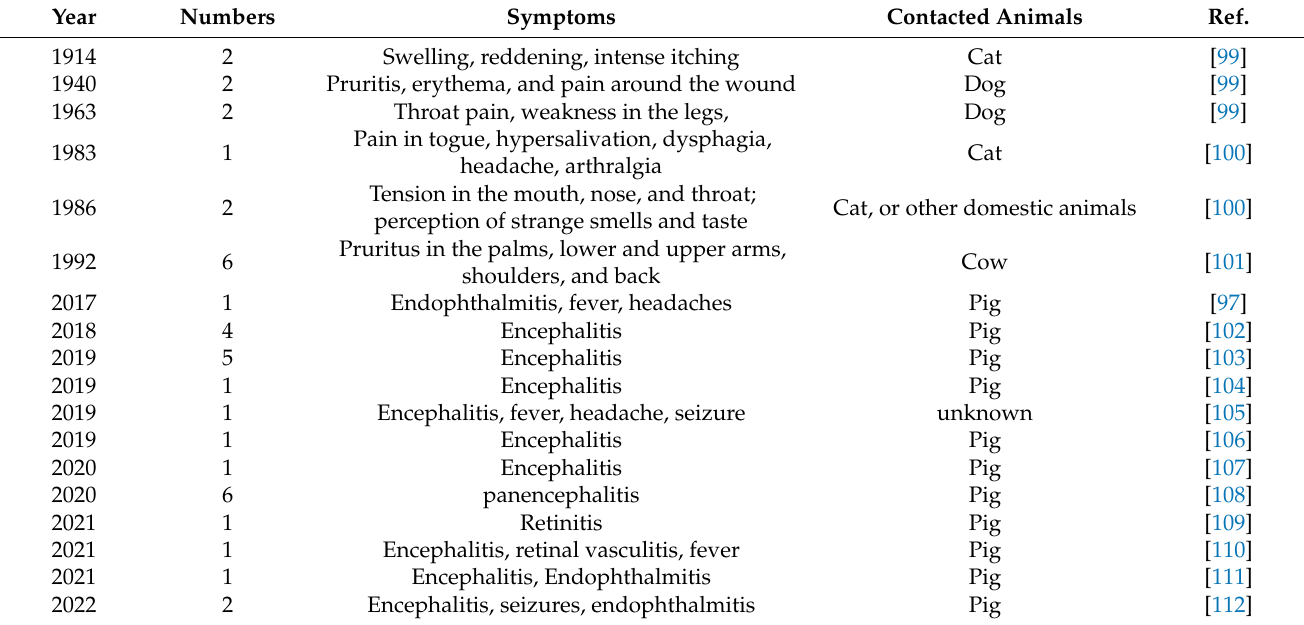
Table 1. PRV infection cases in